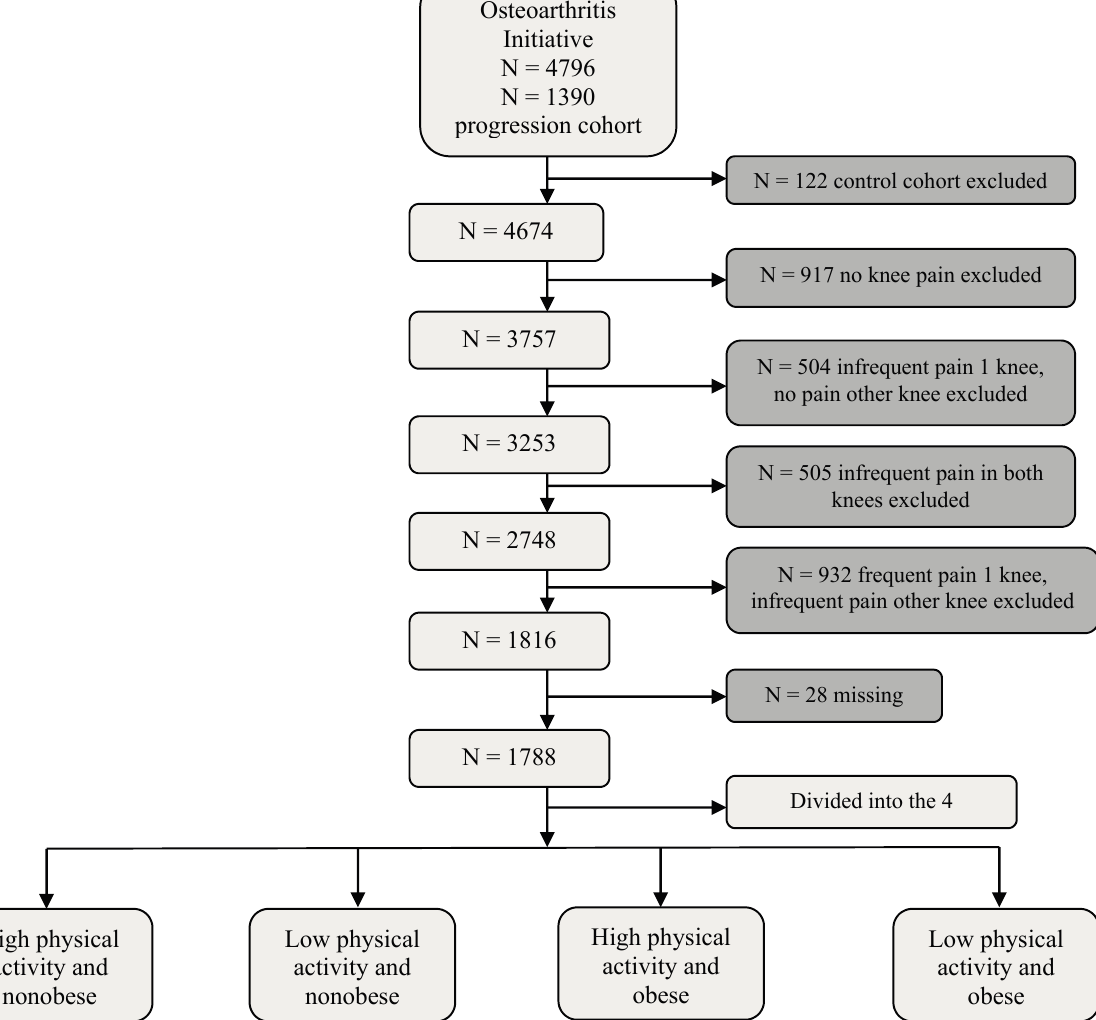
Figure 1. Flow diagram of selection and classification of participants enrolled in the